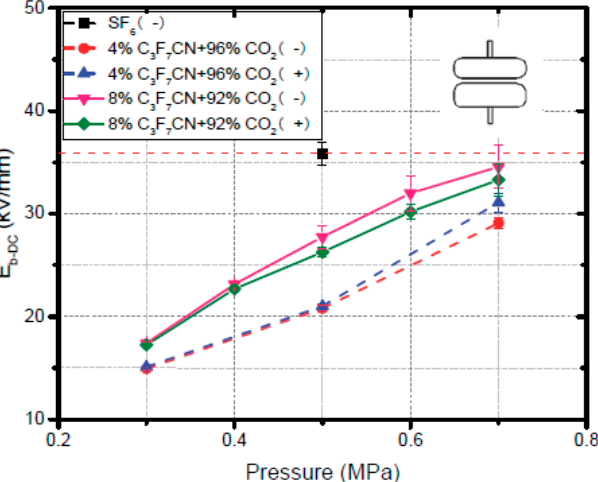
Figure 2. DC breakdown strength of the Novec TM 4710/carbon dioxide (CO 2 ) mixture depending on gas ratio and pressure [57].